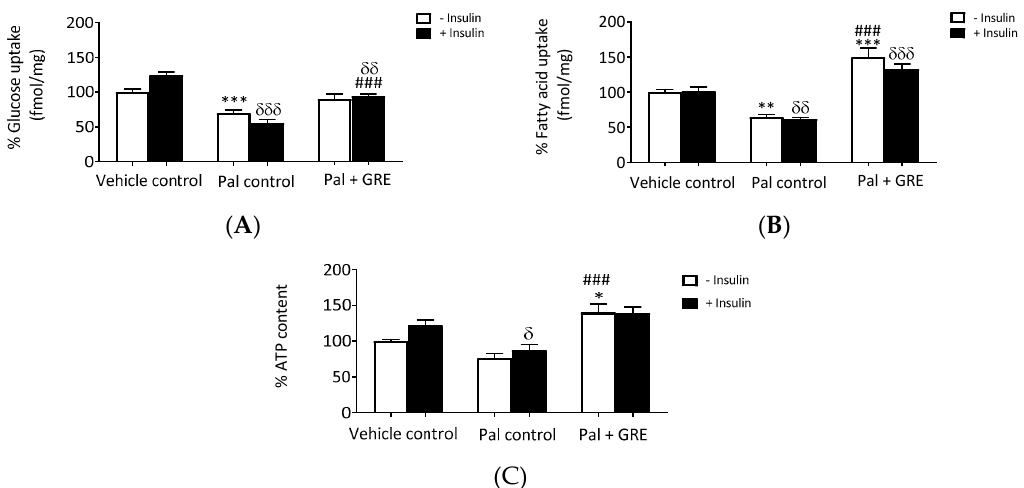
Figure 1. An aspalathin-enriched green rooibos extract (GRE) increased glucose uptake ( A ), palmitate (Pal) uptake ( B ) and ATP content ( C ) in palmitate treated C3A cells. Results are presented as mean ± SEM of three independent experiments. * p < 0.05, ** p ˂ 0.01, *** p < 0.001 versus vehicle control (no insulin), ### p < 0.001 versus Pal control (no insulin). δ p < 0.05, δδ p ˂ 0.01, δδδ p < 0.001 versus insulin-stimulated vehicle control.